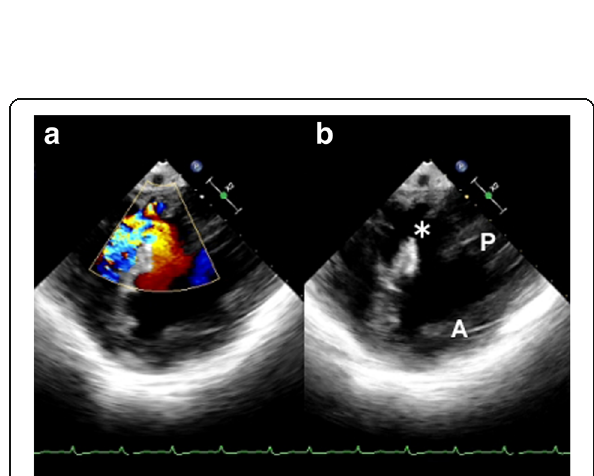
Fig. 2 The preoperative transesophageal echocardiogram. a It showed transseptal interventricular communication with a shunting ratio of 2.4. b The defect (asterisk) located in the posterior septum close to the base of the posteromedial papillary muscle (P). A: anterior papillary